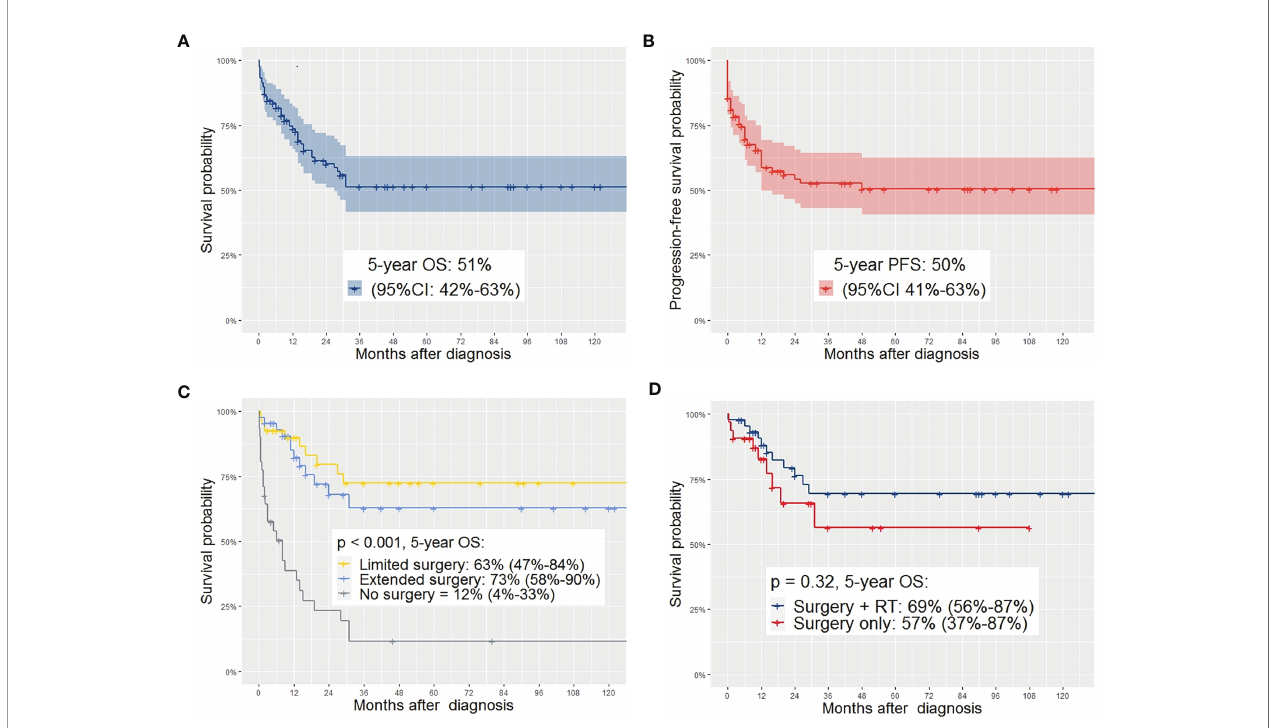
FIGURE 2 | (A) OS of the complete study population; (B) PFS of the complete study population; (C) comparing OS depending on the type of surgery showing signi fi cant higher OS in patients with limited or extended surgery compared to no surgery (95%-CI); (D) comparing OS of patients with surgery plus EBRT with